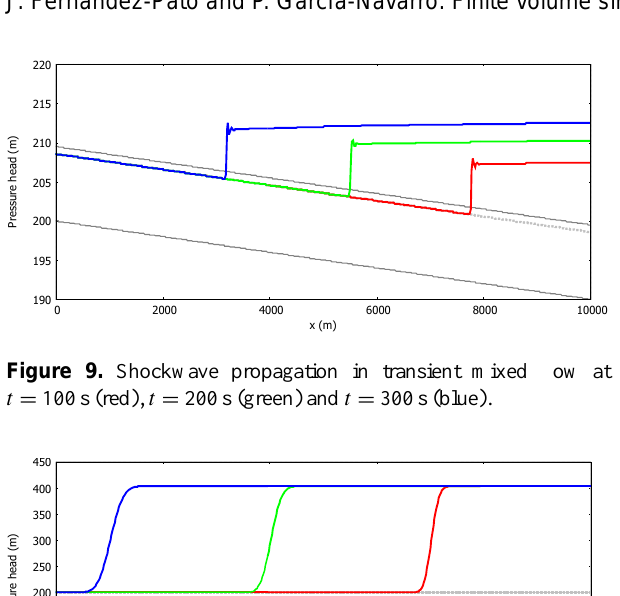
Figure 13. (Scheme of the looped pipe network.